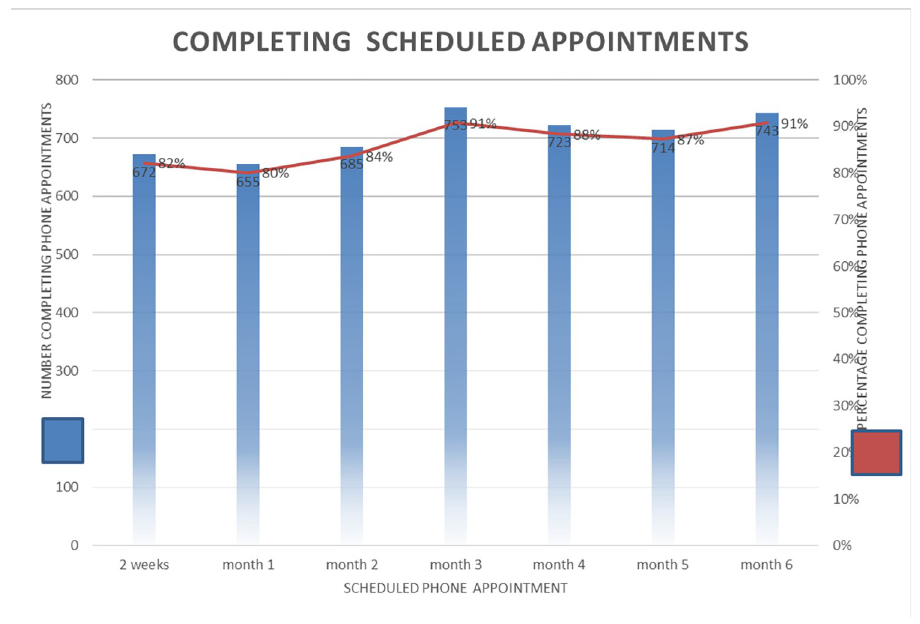
Fig 5. Completion of phone visits by month.